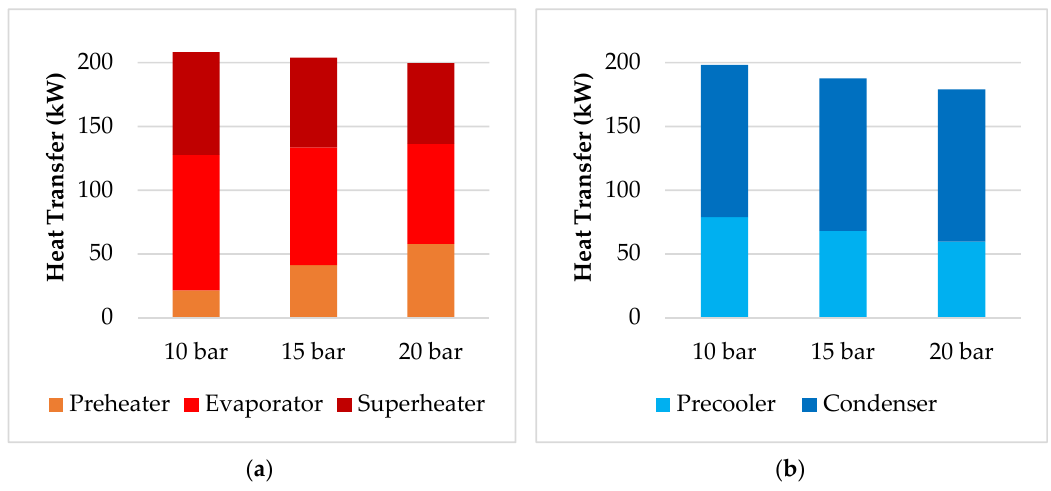
Figure 6. Heat transfer rate in the ( a ) hot and ( b ) cold heat exchangers for 10 bar, 15 bar and 20 bar evaporator pressures.